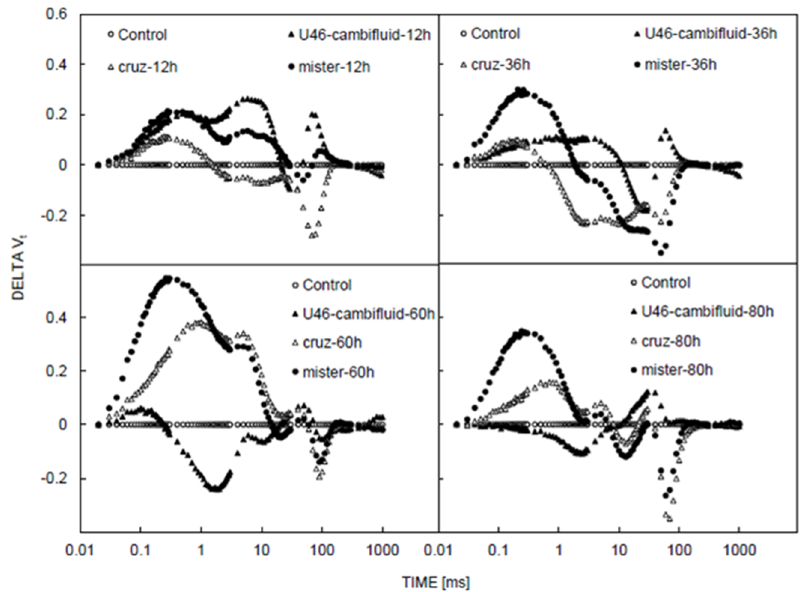
Figure 3. E ff ect of herbicides on OJIP fluorescence rise kinetics. E ff ects of di ff erent herbicides on OJIP Figure 3. Effect of herbicides on OJIP fluorescence rise kinetics. Effects of different herbicides on OJIP fluorescence rise kinetics analyzed by calculating the di ff erence in the variable fluorescence curves fluorescence rise kinetics analyzed by calculating the difference in the variable fluorescence curves ( ∆ Vt) at di ff erent time intervals. (  Vt) at different time intervals.